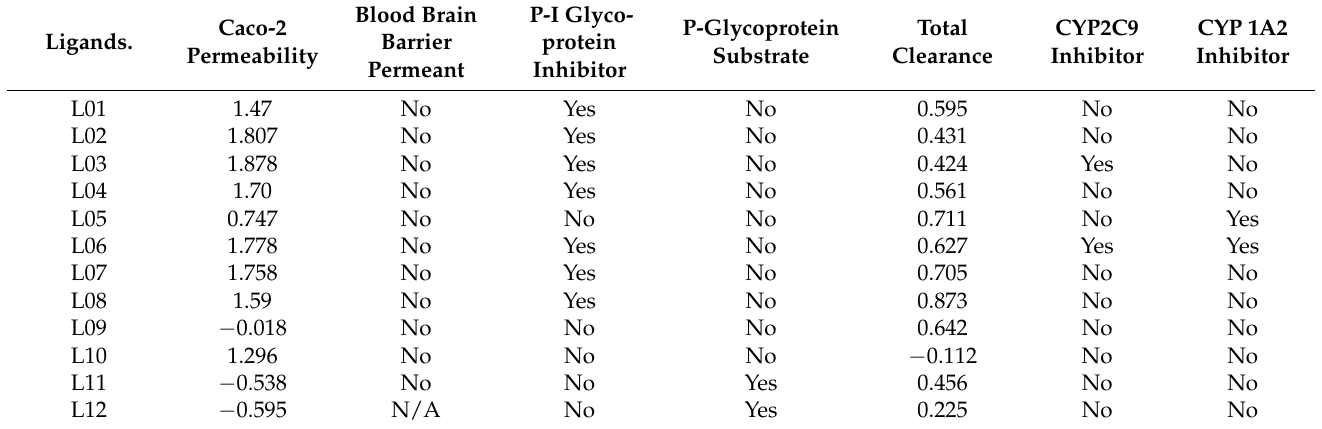
Table 7. Data of the ADME properties.